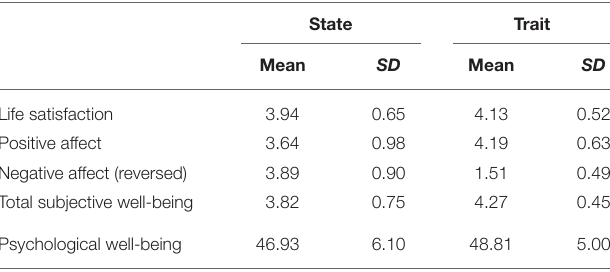
TABLE 5 | Subjective and psychological well-being